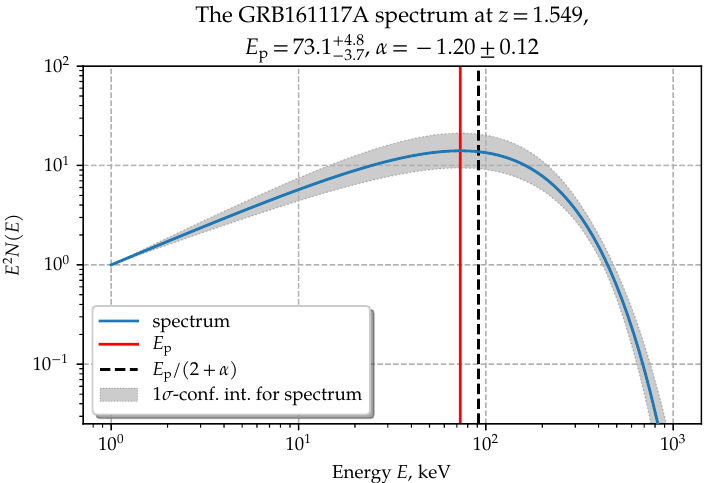
Figure 1. LGRB161117A spectrum in the CPL model as an example. Values of α , E p and their errors was found at Swift database https://swift.gsfc.nasa.gov/results/batgrbcat/GRB161117A/ web/GRB161117A.html (accessed on 12 January 2022) (referred as Ph_index and Epeak